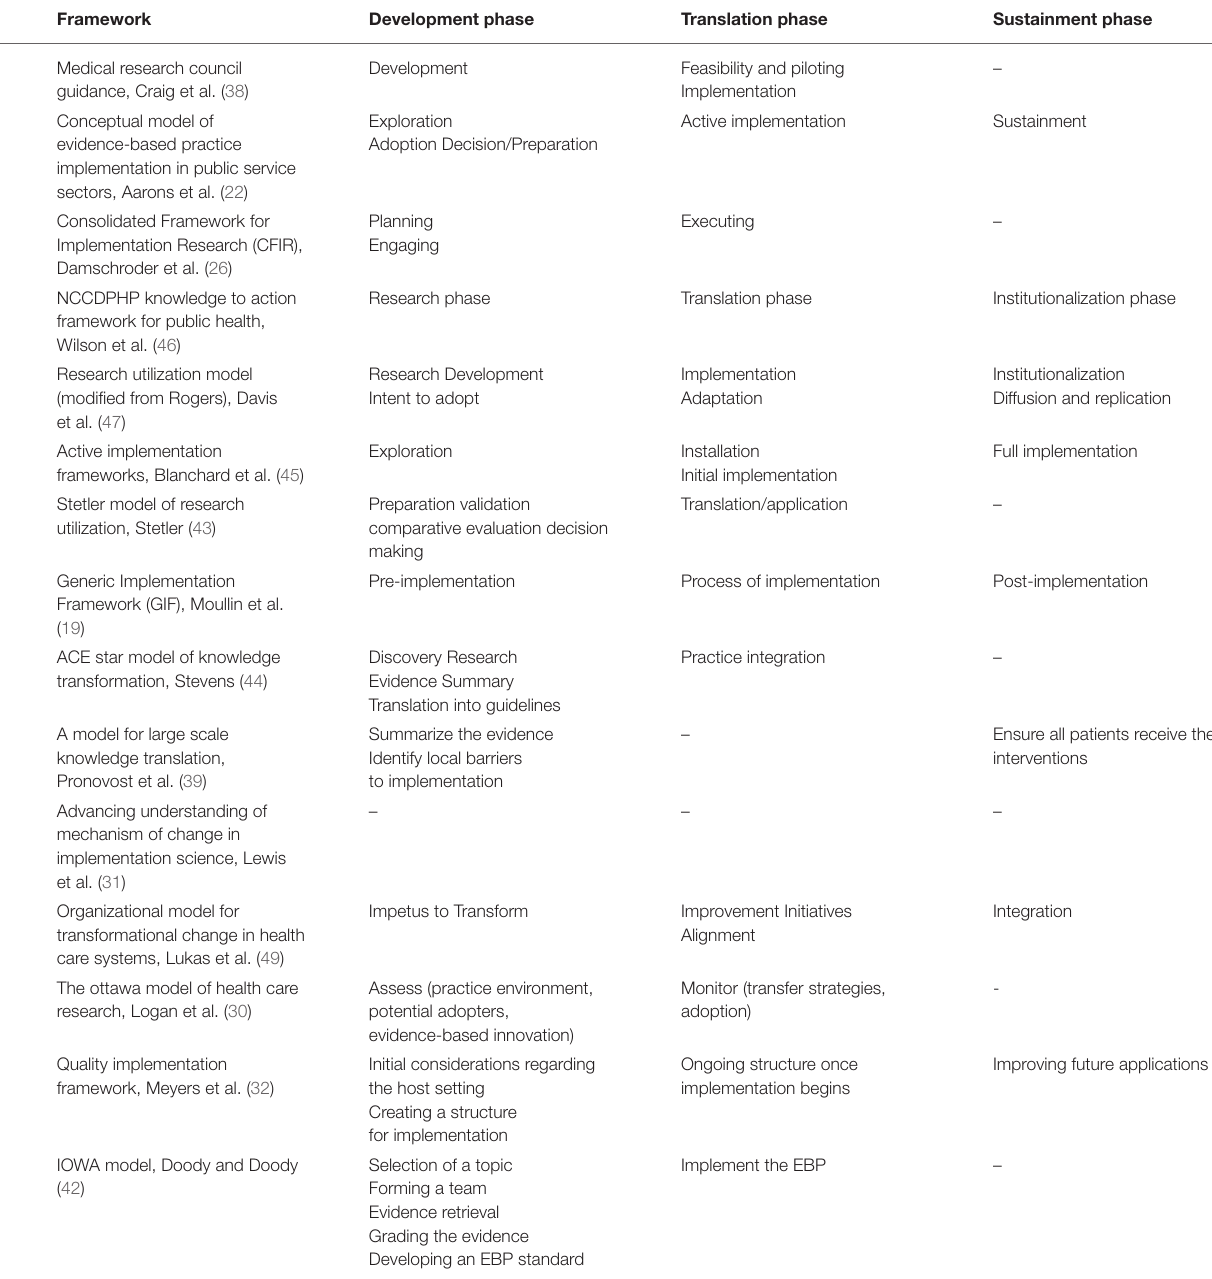
TABLE 6 | Overview of process models in relation to a development phase, translation phase and sustainment